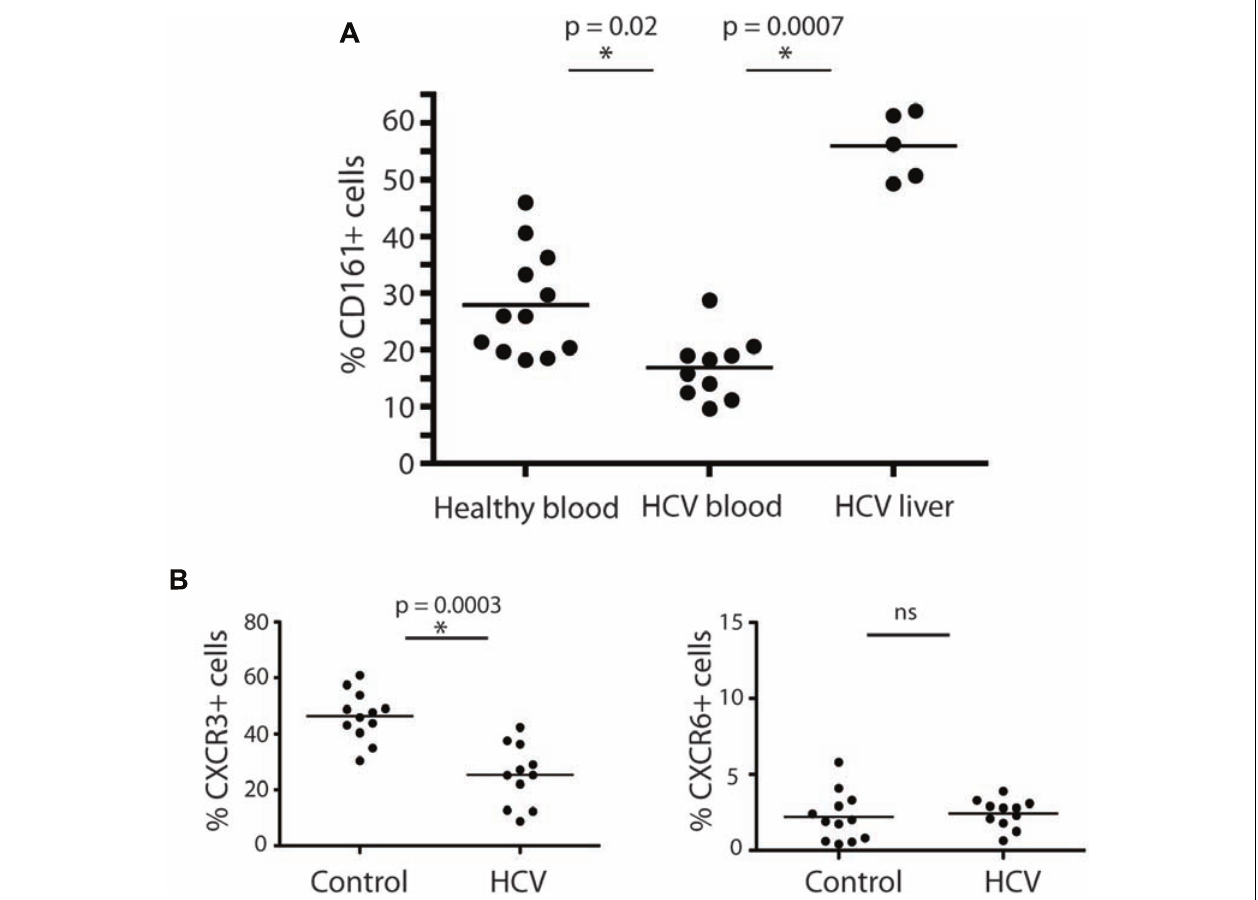
FIGURE 3 | CD161 + CD4 + T cells in blood and liver in HCV infection. CD161 + CD4 + CD3 + T cell frequencies were examined in blood from healthy donors, HCV + chronically infected donors and liver derived lymphocytes, studied ex vivo (A) . Percentage CD161 + cells amongst CD4 + T cells in liver explants, PBMC from HCV + donors and PBMC from healthy donors are shown.The 15 HCV + donors studied in the analysis of PBMC were additional to those inTable 1 and comprised persistently infected donors (eight genotype